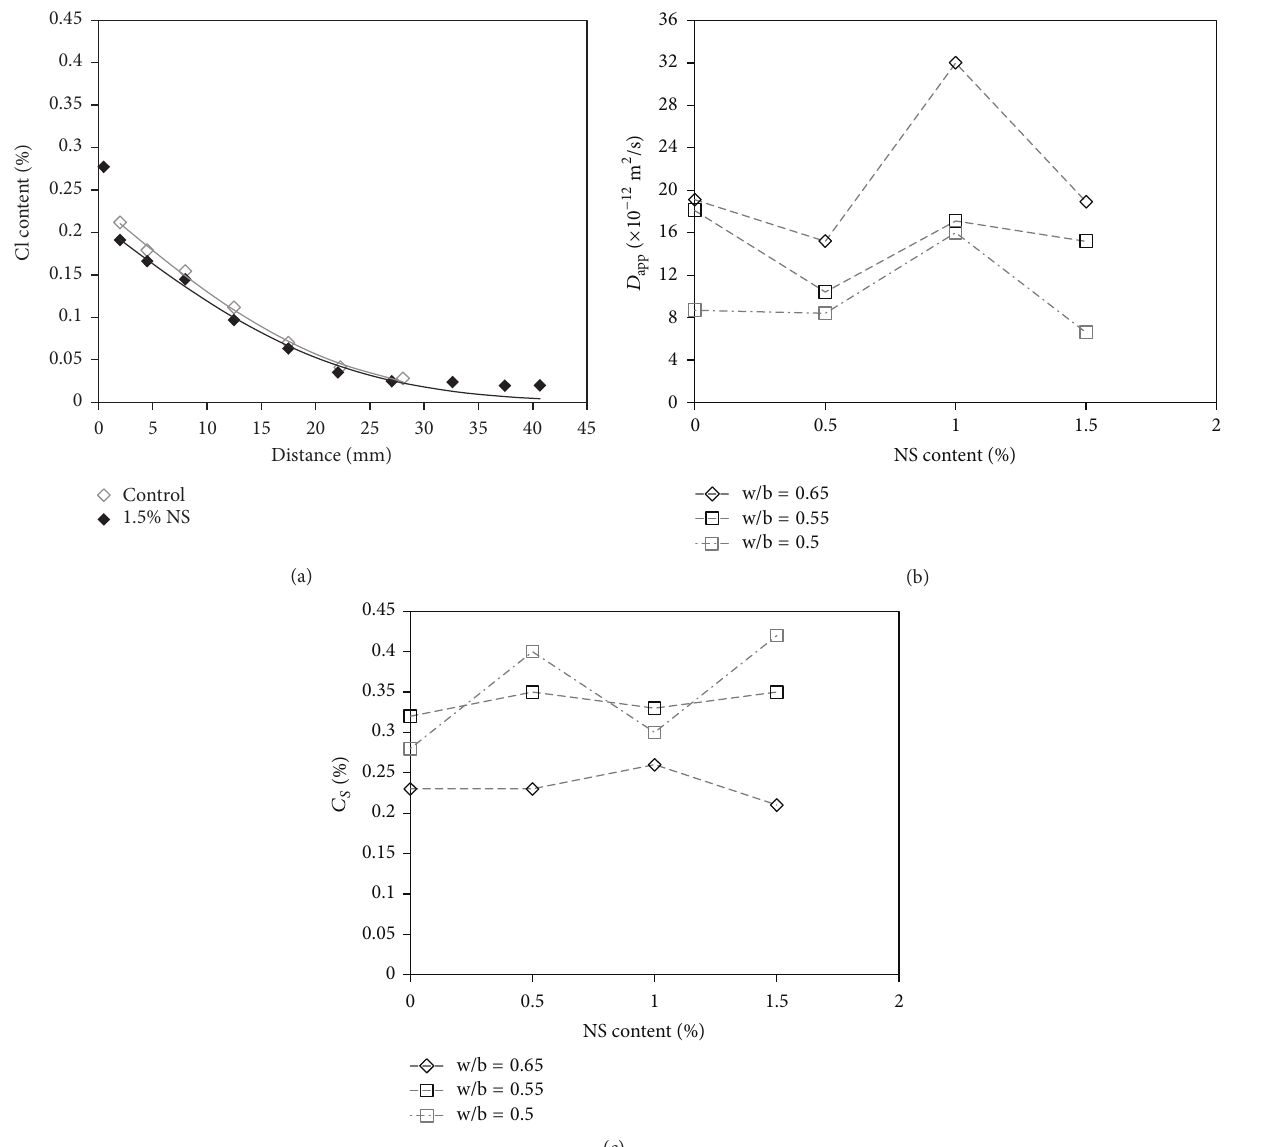
Figure 6: (a) Example of chloride profile for concrete with w / b = 0.65 for control and 1.5% NS addition. (b) Apparent chloride diffusion coefficients and (c) surface chloride content with respect to concrete mass as a function of NS